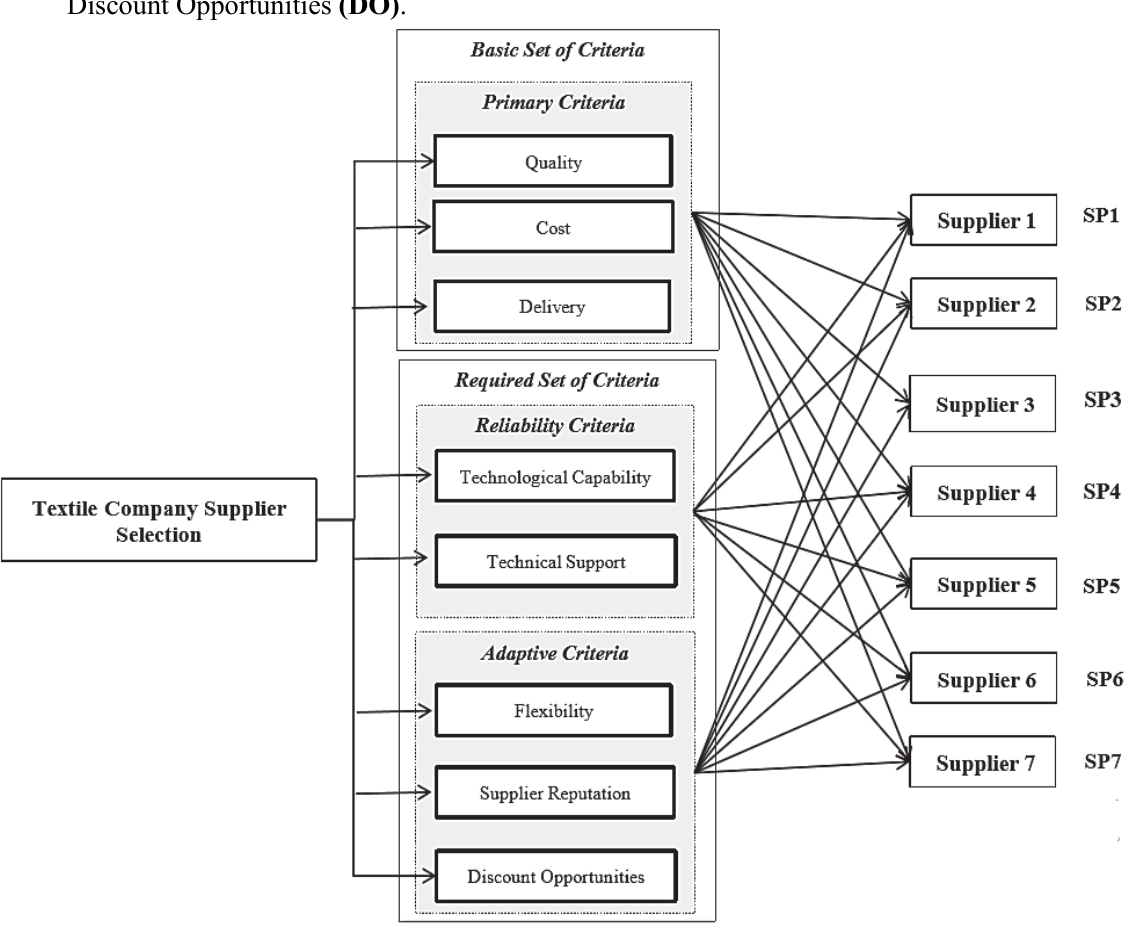
Fig. 1. Set of criteria for selecting the right supplier in Turkish Textile Company The grey comparison matrix is constructed with the support and the assessments of this qualified team. The grey comparison matrix is illustrated in detail in Table 5.